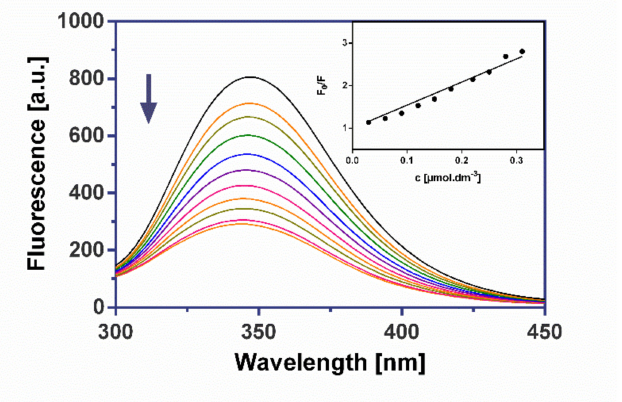
Figure 13. Fluorescence quenching spectra of BSA in presence of complex 3 . Inset: the corresponding Stern–Volmer plot for 3 at 25 ◦ C.